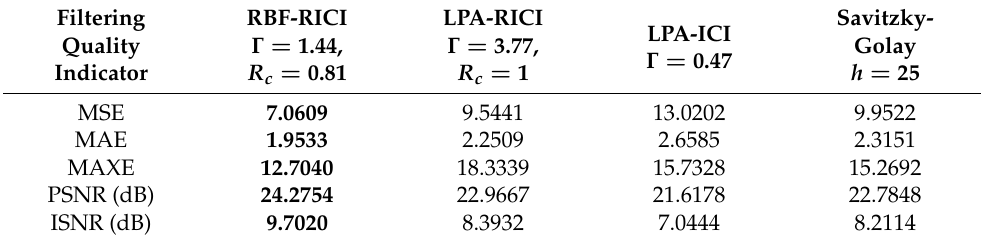
Table 30. Piece-Regular signal (SNR = 7 dB)—Filtering results.